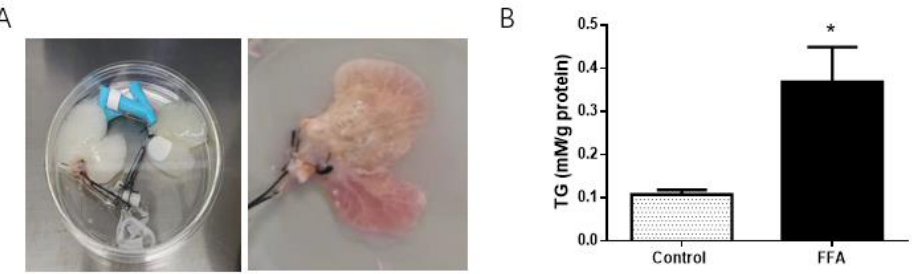
Figure 1. Establishment of a 3D model of NAFLD based on the tissue-engineered liver. ( A ) The process of model preparation. ( B ) Intracellular TG measurement of the FFA group liver. * p < 0.05.